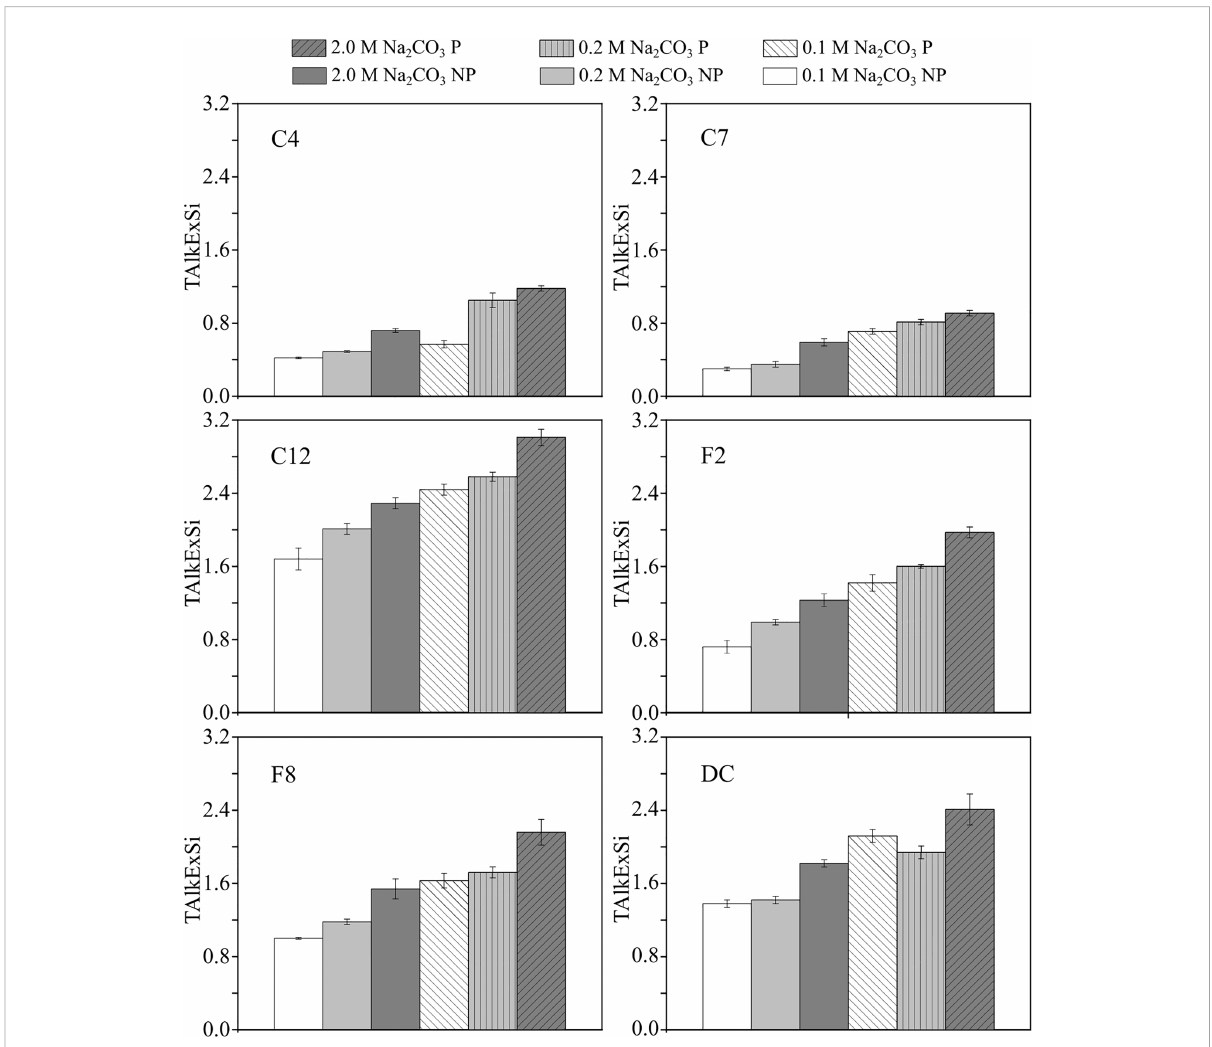
FIGURE 4 The total alkaline extracted silica content (TAlkExSi) of sample C4, C7, C12, F2, F8, DC using 0.1 M, 0.2 M, 2.0 M Na 2 CO 3 solution (P vs. NP). The results presented are the SiO 2 % extracted after 8 h. More SiO 2 % was extracted in a high concentration of the alkaline solution and after the pre- treatment